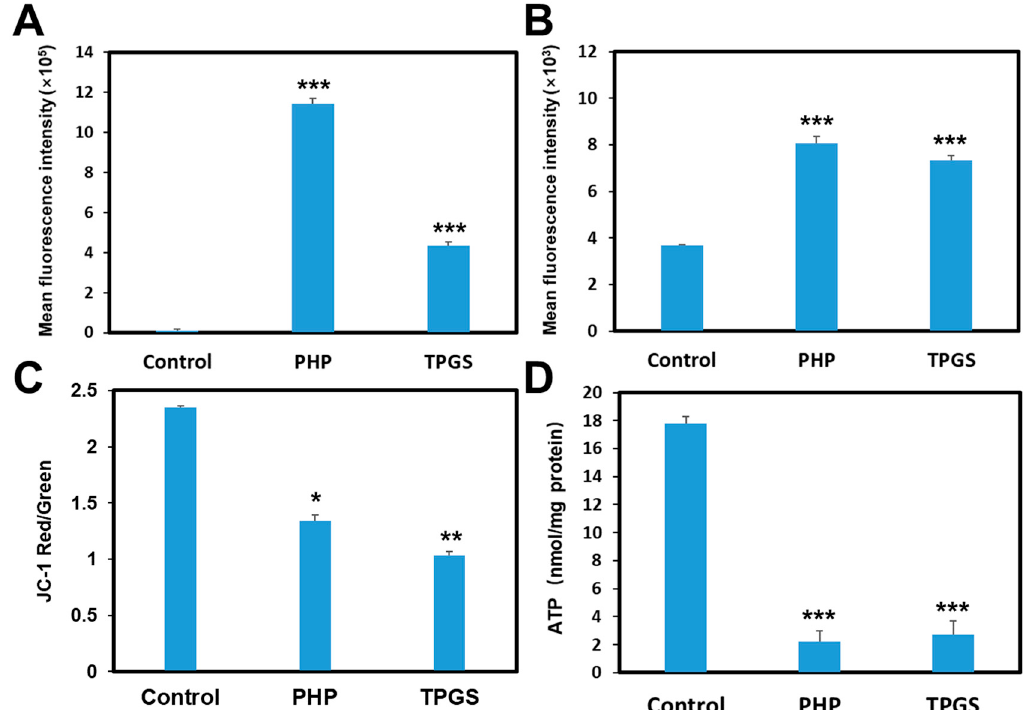
Figure 8. The cellular effects of PHP in MCF-7/ADR cells. The effects of different micelles on Rh123 accumulation ( A ); inhibition of Rh123 efflux ( B ); mitochondrial membrane potential ( C ); and intracellular ATP ( D ) were shown. The concentrations of PHP and TPGS were 250 µ g/mL. Data as mean ± SD ( n = 3). * p < 0.05, ** p < 0.01, *** p < 0.001.